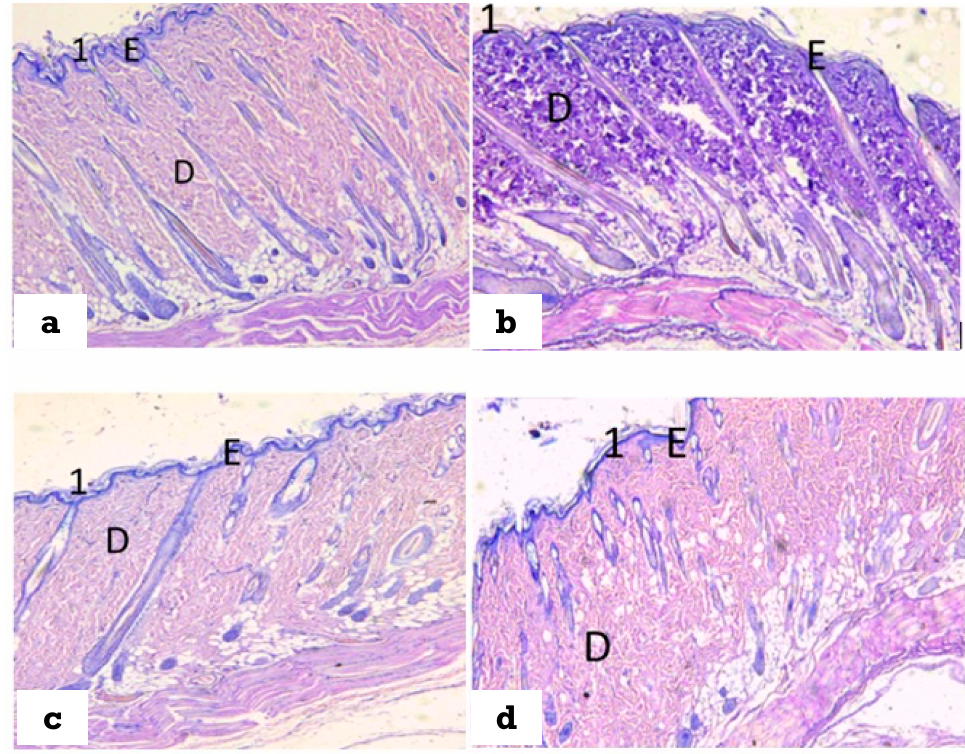
Figure 10. Section of skin: ( a ) normal skin, ( b ) diabetic wound, ( c ) non- diabetic non -treated wound, and ( d ) diabetic wound treated with ZnONPs-2@CF; H&E stain, Scale Bar: 500 µ . 1: stratum corneum, E: epidermis, D: Dermis.